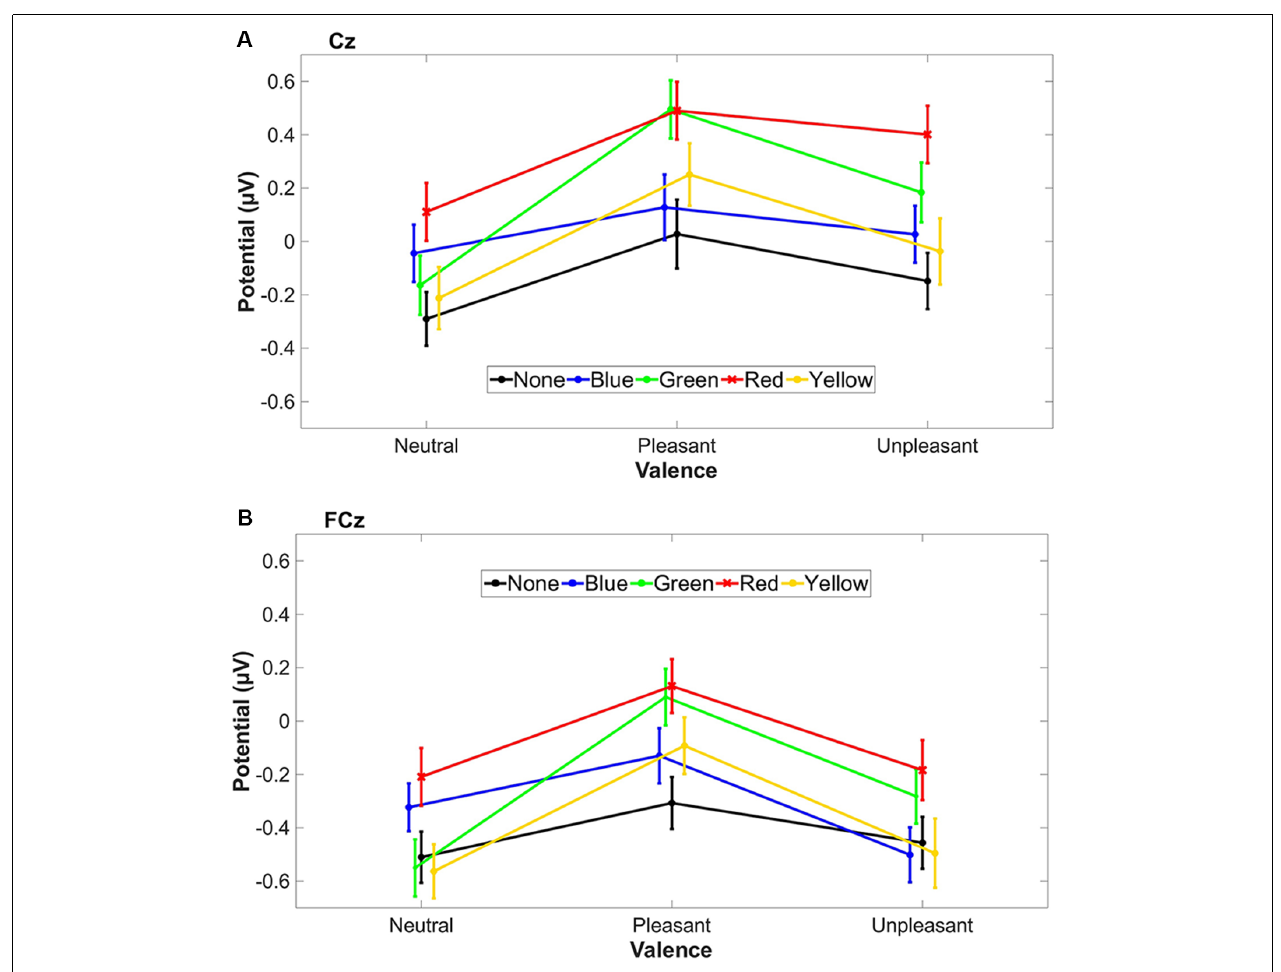
FIGURE 5 | The standard error of the mean (SEM) and the mean LPP amplitude (500–1,500 ms) of tinted lens conditions are plotted for each stimulus valence condition for Cz (A) and FCz (B) . Valence conditions are connected with a line for better visualization.